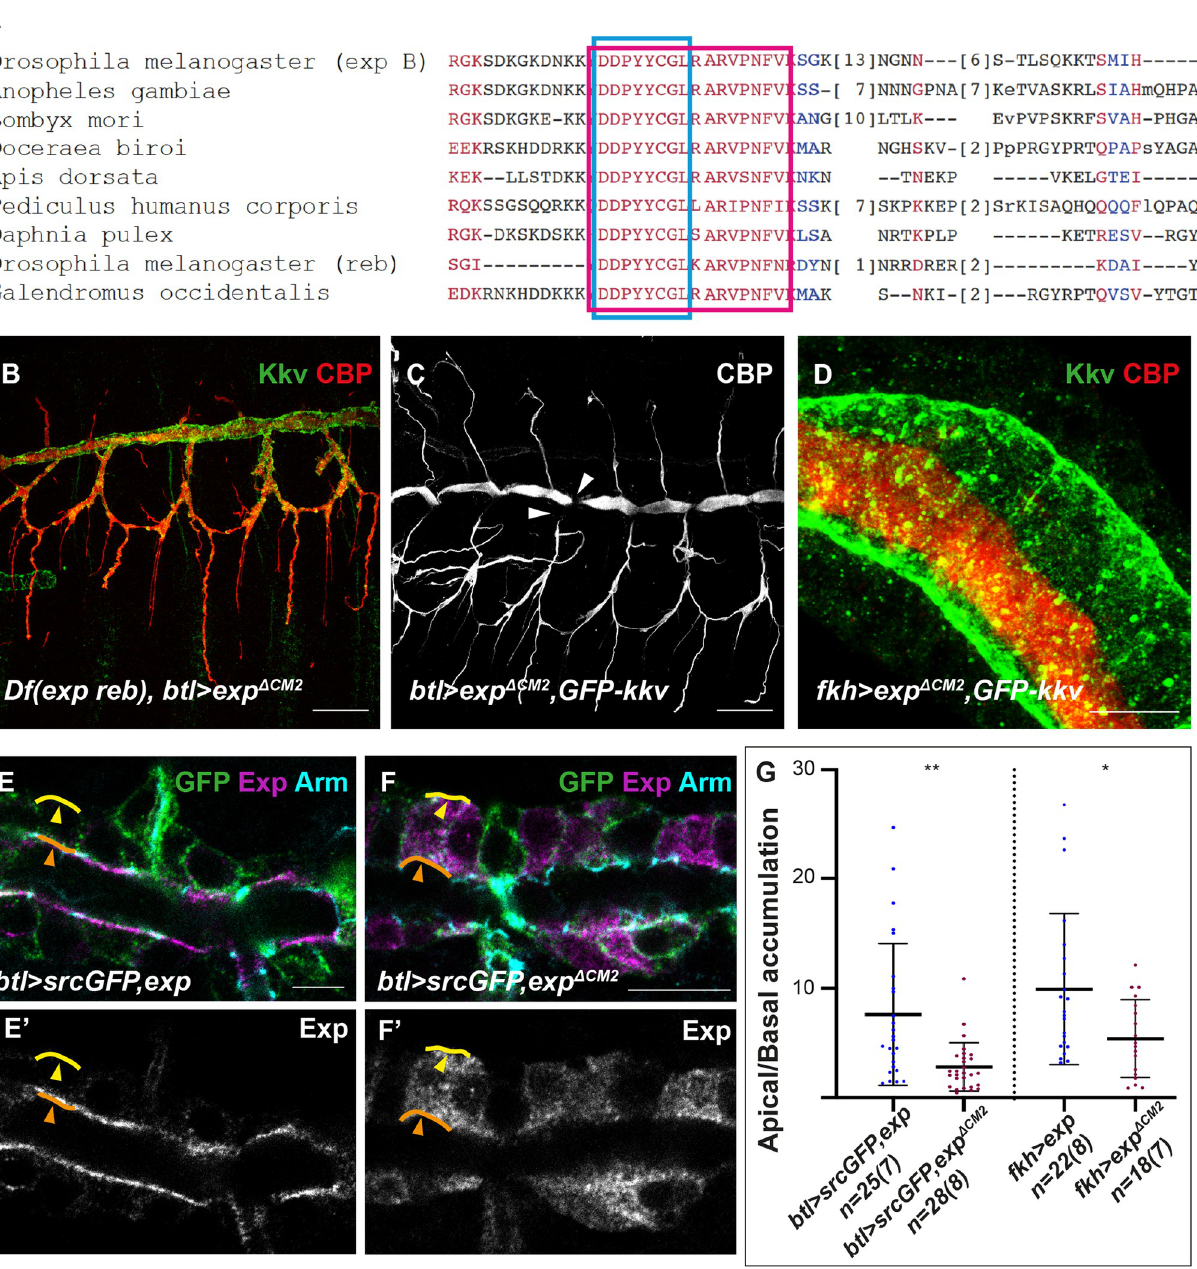
Fig 2. Analysis of the role of the CM2 domain of Exp/Reb. ( A ) Alignment of amino acids (aa) sequences of the isoform B of Exp (aa 356–433) and homologs; the blue square indicates 8 aa highly conserved, the red square includes 9 aa less conserved. ( B - D ) Show projections of confocal sections and ( E - F ) show single confocal sections. ( B ) The overexpression of exp Δ CM2 in an exp reb mutant background rescues the lack of extracellular chitin deposition. ( C , D ) The simultaneous expression of exp Δ CM2 and GFP-kkv produces morphogenetic defects in the trachea (arrowheads in C ) and ectopic chitin deposition in the lumen of salivary glands ( D ). ( E , F ) Overexpressed Exp localises mainly in the apical region (orange arrowheads) with respect the basal domain (yellow arrowheads), while the apical accumulation of overexpressed Exp Δ CM2 is less conspicuous ( F ). ( G ) Quantifications of accumulation of Exp and Exp Δ CM2 in apical versus basal region. n corresponds to the number of ratios analysed (apical/basal ratio per cell), and brackets indicate the number of embryos used. Ratios were obtained from the apical (orange line in E ) and basal (yellow line in E ) domains of single cells in trachea and salivary glands. The underlying data for quantifications can be found in the S1 Data. Scale bars B , C : 25 μ m; D - F : 10 μ m.